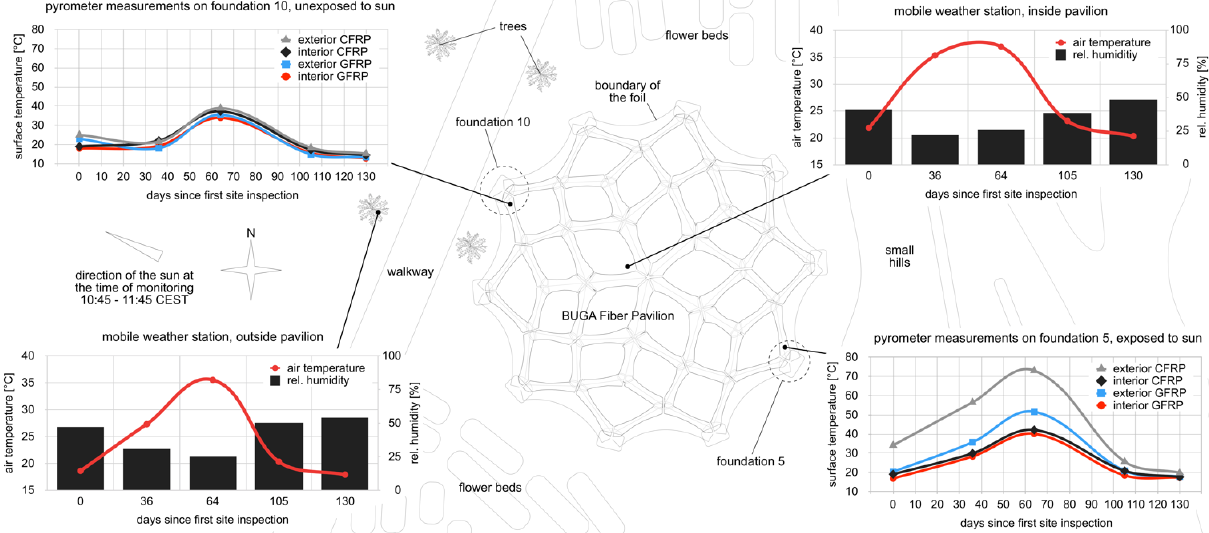
Figure 4. Floor plan of the BUGA Fiber Pavilion. The in situ measurements are indicated at their locations.